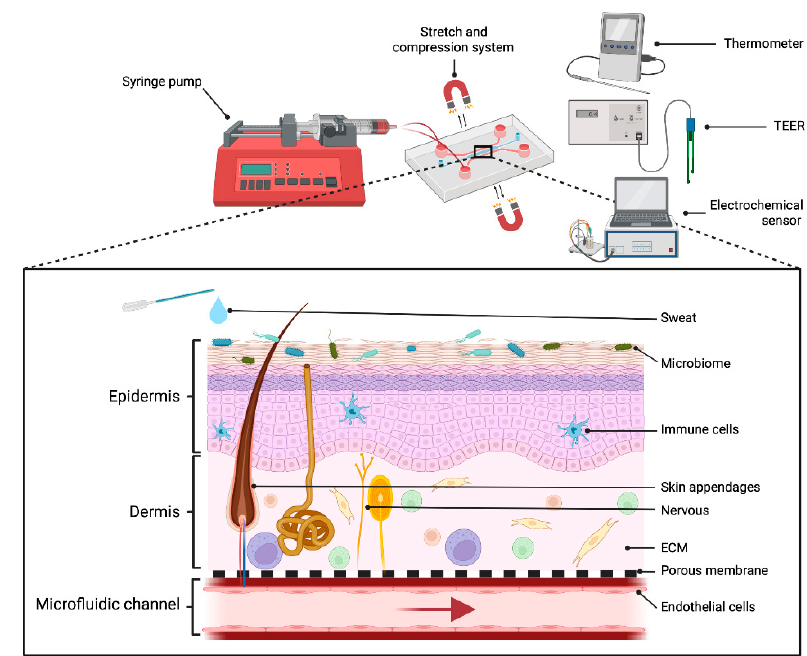
Figure 6. Biological and mechanical requirements of an optimized SoC. Adapted from “Anatomy of the skin”, by BioRender.com (2022). Retrieved from https://app.biorender.com/biorender-templates, accessed on 27 June 2022.